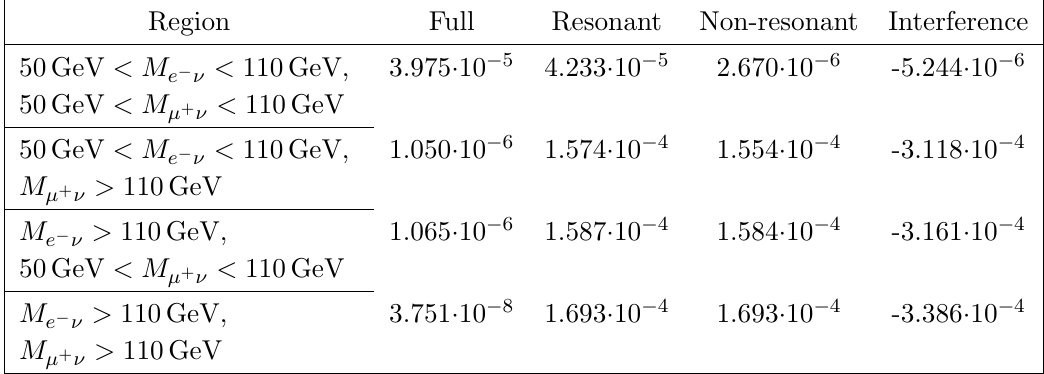
Table 2. Cross-sections (pb) in di(cid:11)erent M